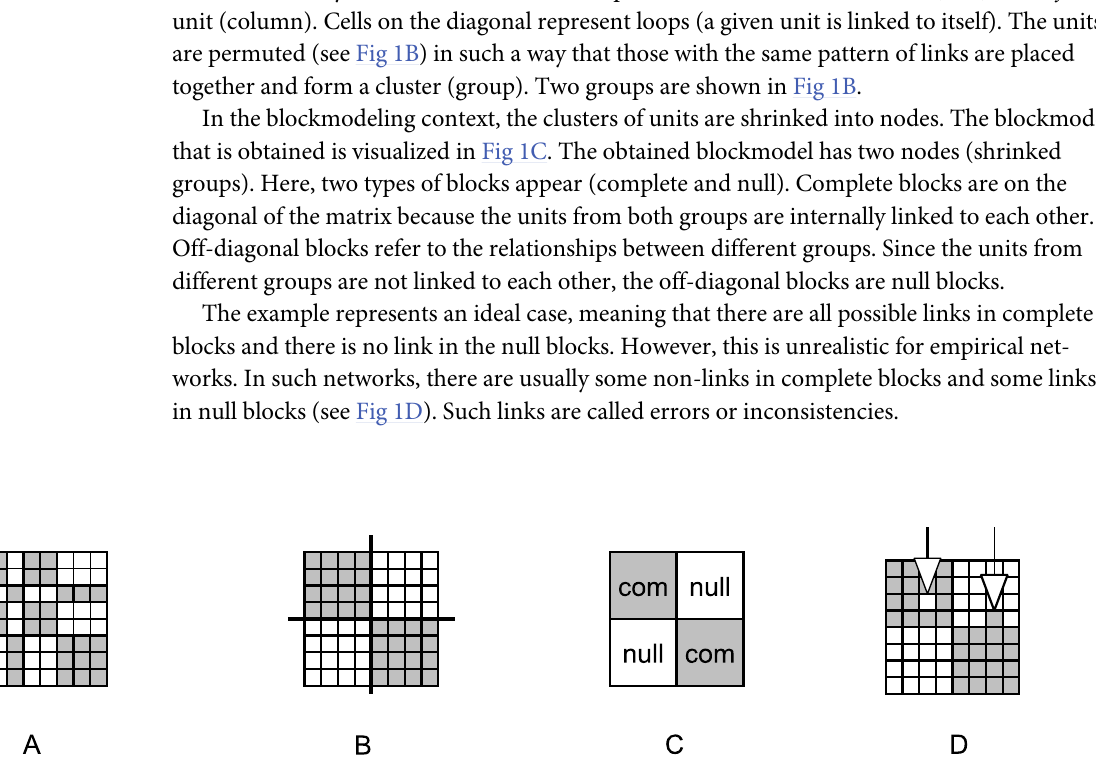
PLOS ONE | https://doi.org/10.1371/journal.pone.0226801 January 15,